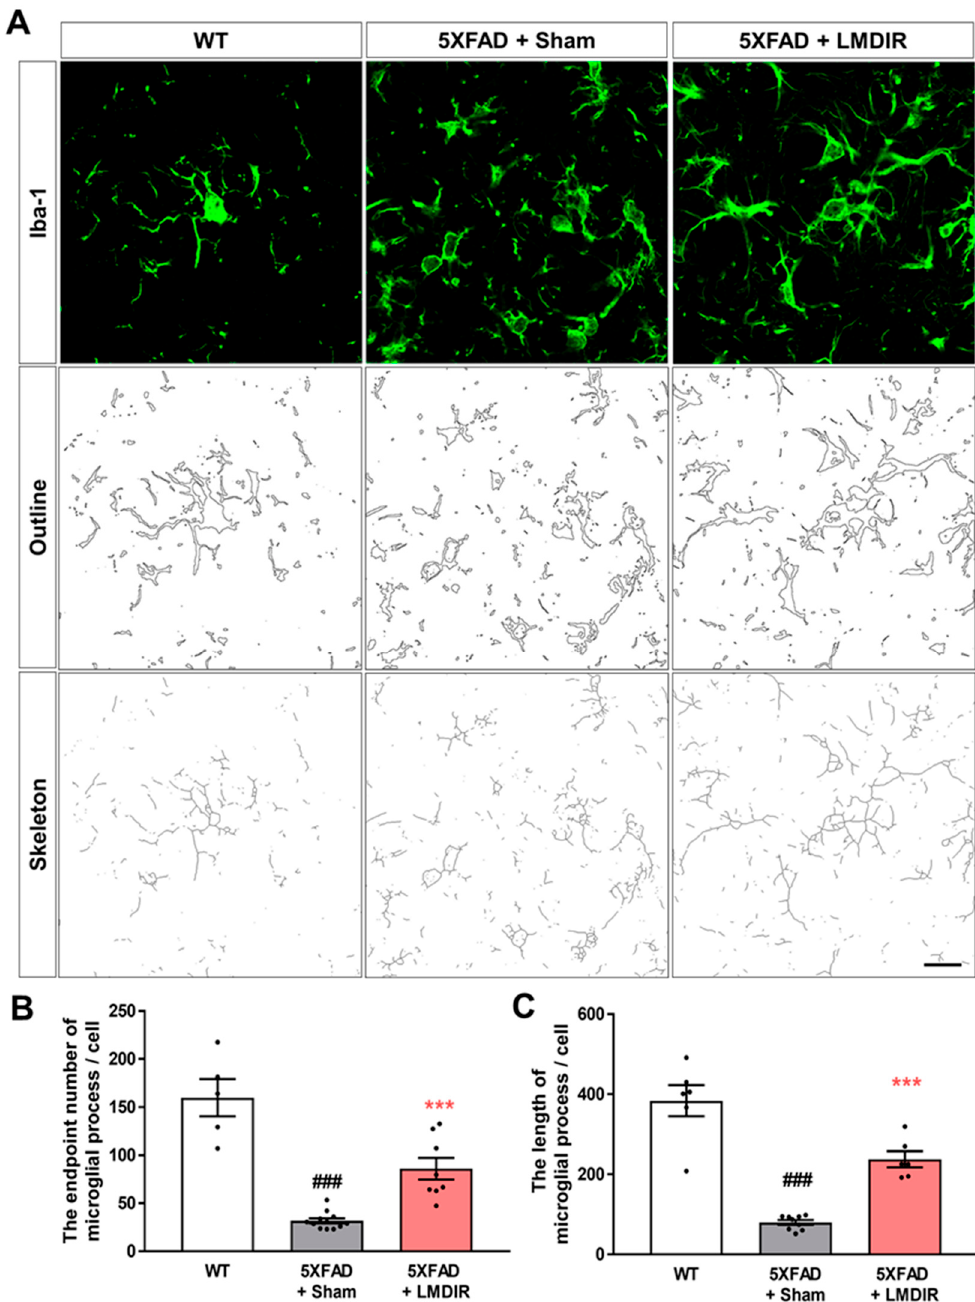
Figure 4. The effect of LMDIR on transformation from amoeboid to ramified microglial morphology changes in the subiculum of 5XFAD mice. ( A ) Representative images of immunofluorescent staining, cell outlines and skeleton structure of the subiculum for Iba-1, a marker of microglia. ( B ) The number of microglial process endpoints was significantly lower in the subiculum of 5XFAD mice than that of the WT mice. In contrast, the number of microglial process endpoints was significantly higher in the subiculum of LMDIR-exposed 5XFAD mice than that of the sham-exposed 5XFAD mice. ( C ) Microglial process length was significantly shorter in the subiculum of 5XFAD mice than that of the WT mice. However, microglial process length was significantly longer in the subiculum of LMDIR-exposed 5XFAD mice than that of the sham-exposed 5XFAD mice. Data are presented as mean ± SEM ( n = 7 in each group). ### p < 0.001: WT mice versus sham-exposed 5XFAD mice. *** p < 0.001: sham-exposed 5XFAD mice versus LMDIR-exposed 5XFAD mice. Scale bar = 20 µ m. LMDIR, low–moderate dose ionizing radiation; Iba-1, ionized calcium-binding adaptor molecule 1.